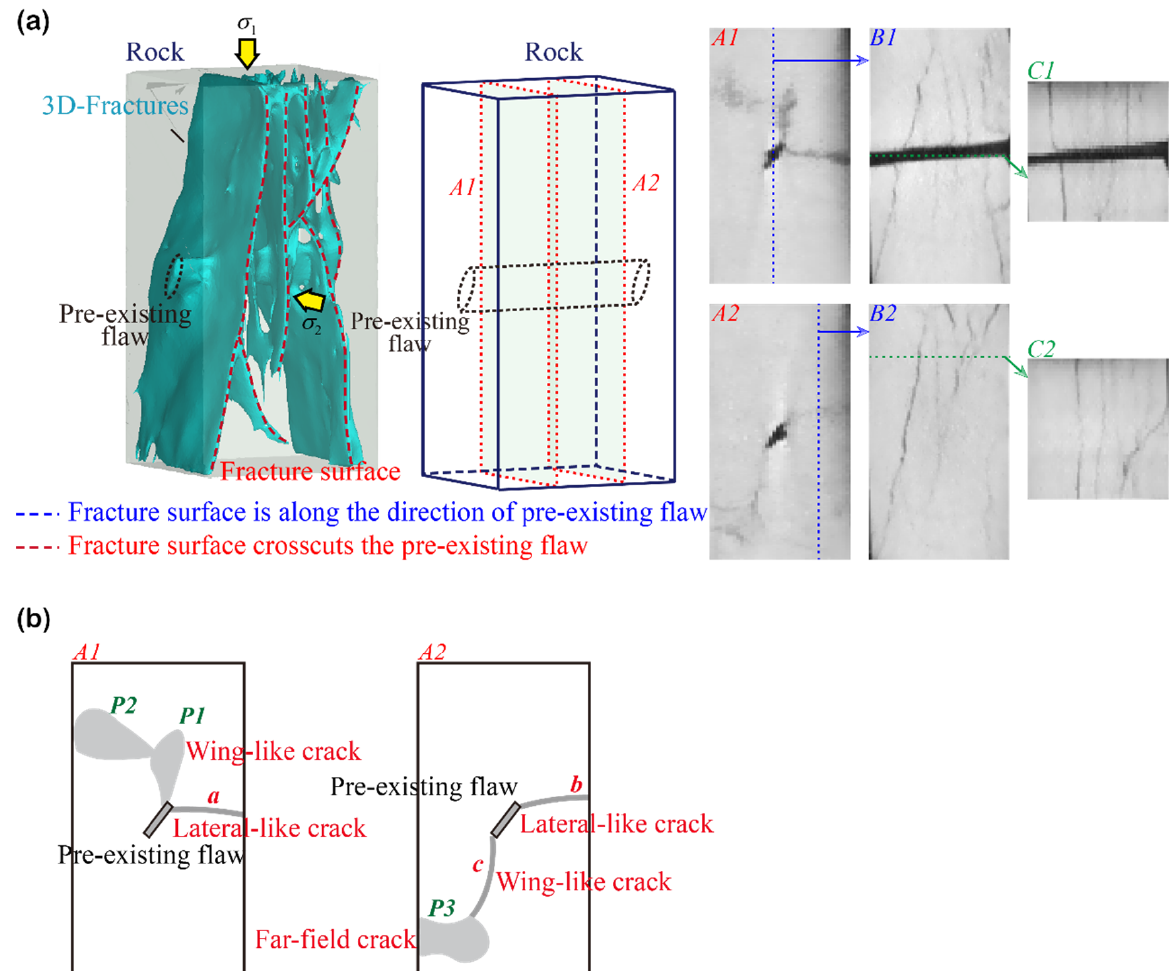
Figure 7. ( a ) Distribution internal fissures in rocks with prefabricated fissures under the BT − 2 condition; ( b ) Various crack types from a single fissure identified.